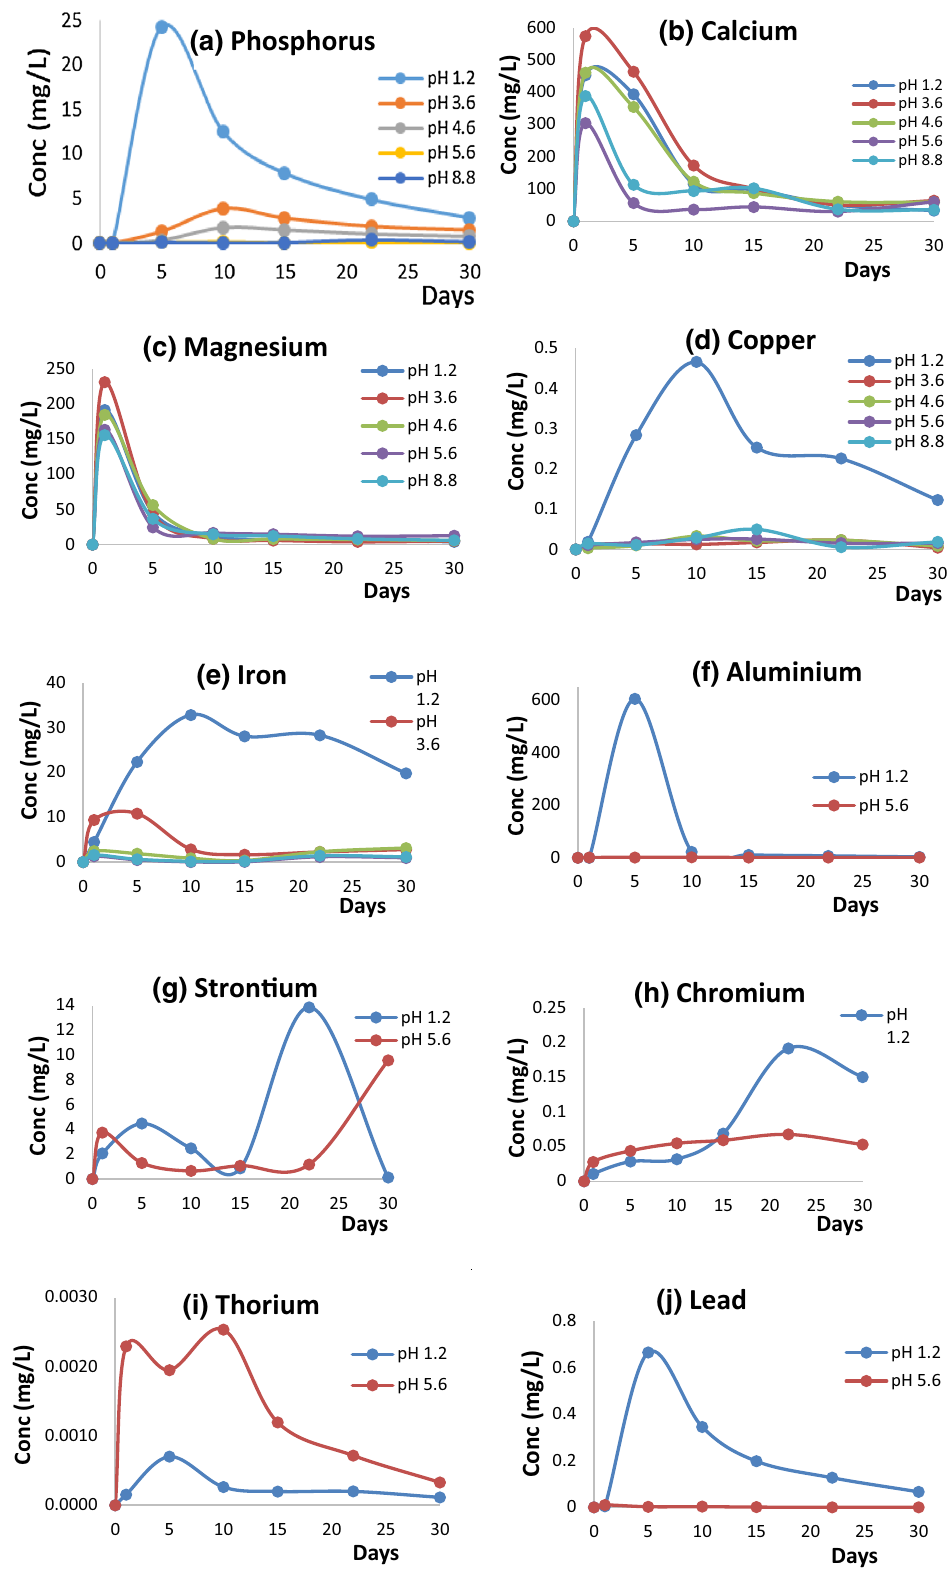
Figure 5. The dissolution of PG organic over the period of 1 month in amended sandy soil